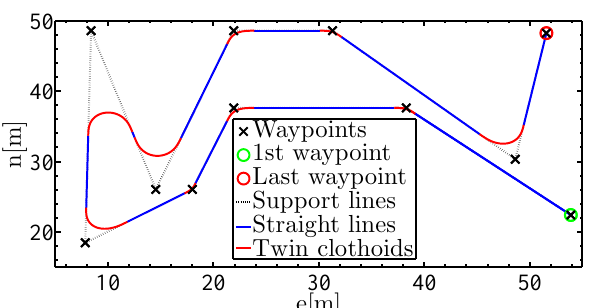
Figure 4: Example of path using approximating curves.